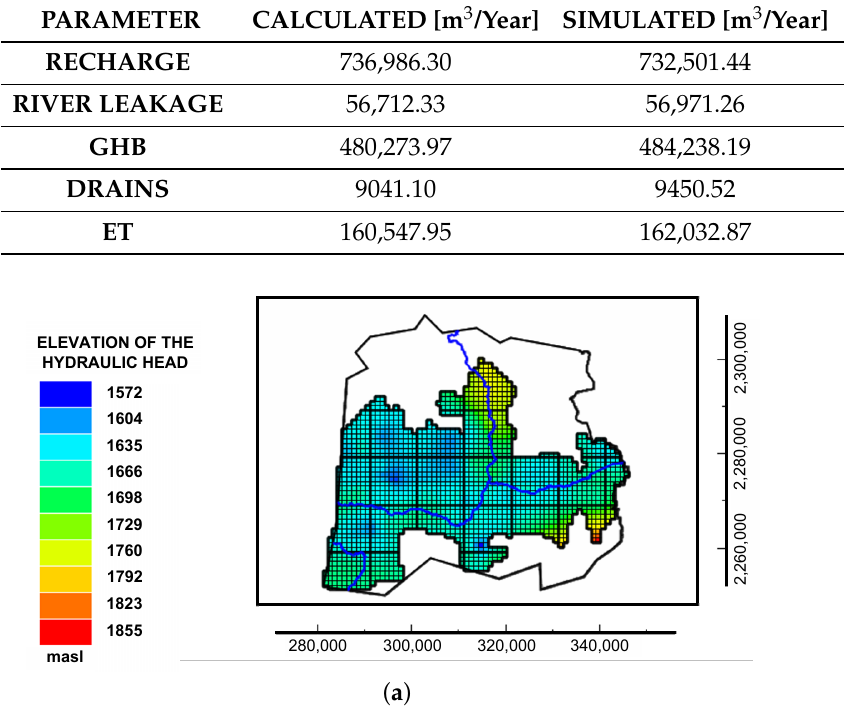
Figura 2.5: Cargas hidr´aulicas en Estado Estacionario de la temporada de Secas, donde la mayor carga se representa por el color rojo y la menor carga por el azul oscuro. Figure 10. Cont